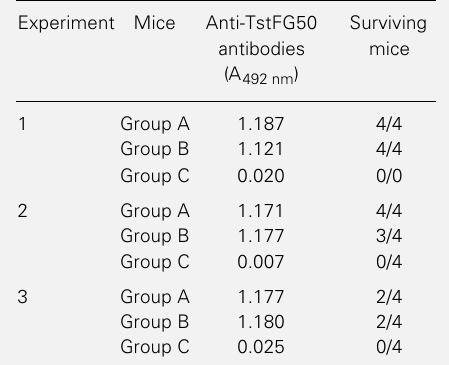
Table 1 - In vivo protection